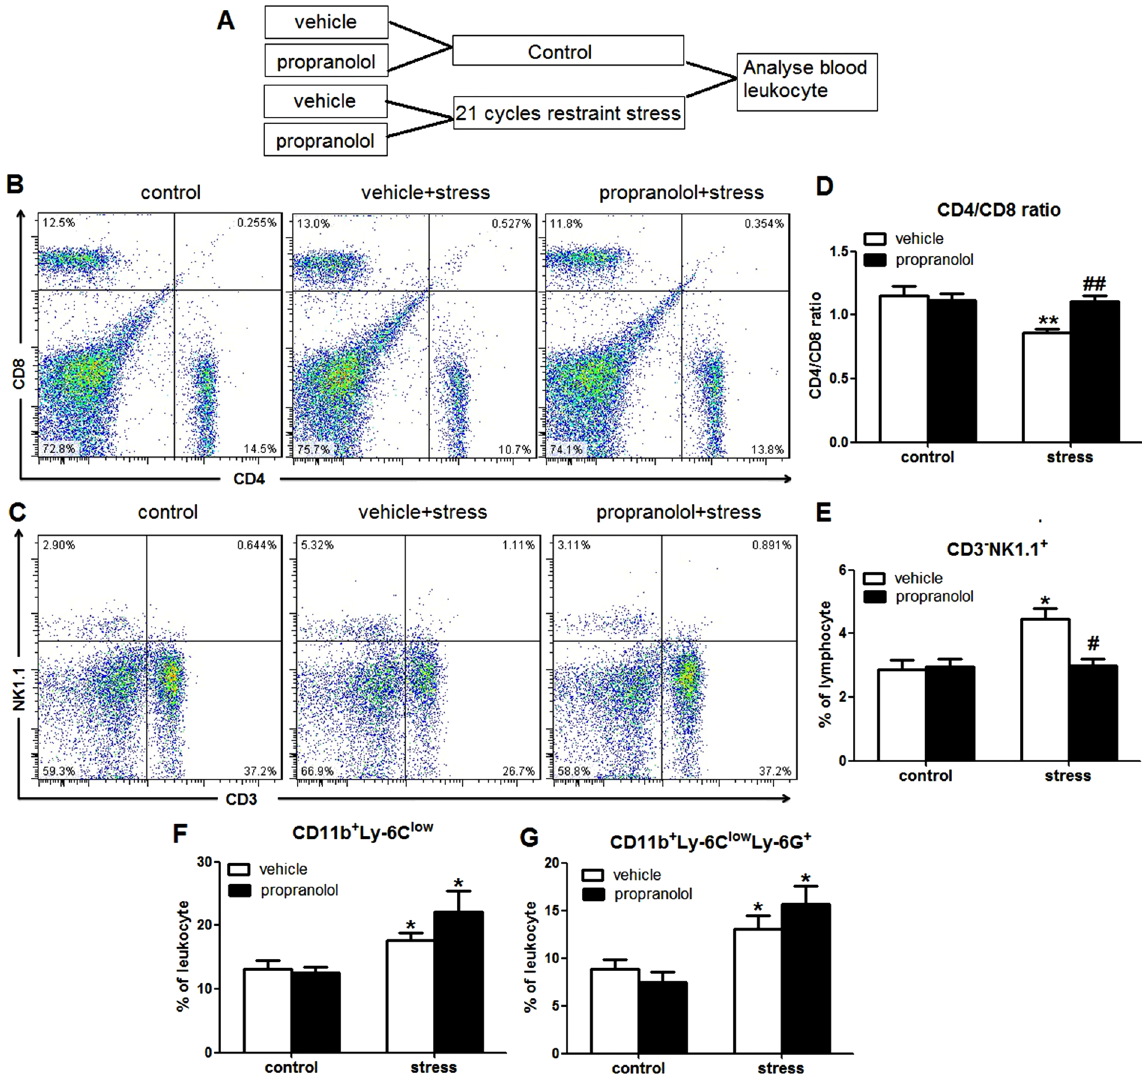
Figure 5. Propranolol could attenuate the changes of the CD4/CD8 ratio and the percentages of NK cells induced by restraint stress. ( A ) Mice were injected sc with vehicle or proraonlol prior to restraint stress each day for 21 days. ( B and C ) Representative plots of CD4 + , CD8 + T lymphocytes ( B ) and NK cells ( C ) in blood. ( D and E ) The changes of the CD4/CD8 ratio ( D ) and the percentages of NK cells ( E ) were blocked by proraonlol. ( F and G ) Proraonlol could not attenuate the changes of the percentages of CD11b + Ly-6 low monocytes ( F ) and CD11b + Ly-6C low Ly-6G + PMN-MDSCs ( G ). Data were shown as mean ± SEM (n = 6). * p < 0.05, ** p < 0.01 vs. control. # p < 0.05, ## p < 0.01 vs.